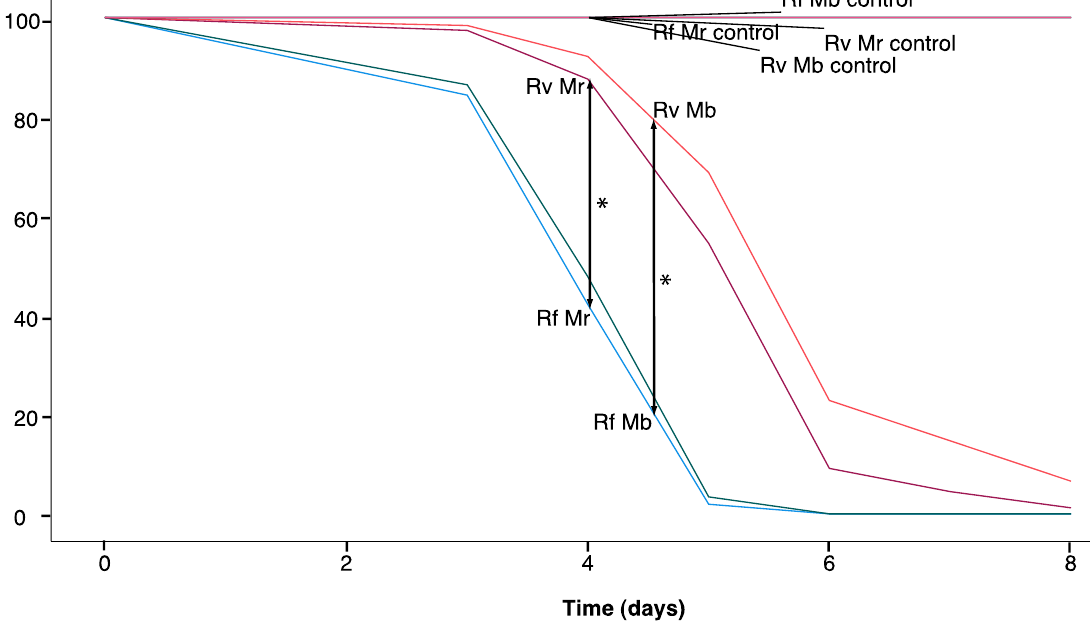
Figure 3. The survivorship of two termites versus one was compared with hazard ratios of death (n = 80 pairs, 96 singletons). Rf corresponds with R. flavipes , Rv with R. virginicus , Mr with M. robertsii and Mb with M. brunneum . Time was log transformed for calculation of the R 2 values. For the survivorship of pathogen-challenged single termites (Figure 4), 47 deaths were observed among 48 individuals, and the mean survival time for R. flavipes (4.21 days) was significantly lower than for R. virginicus (6.17 days)(Breslow, chi-square = 33.927, df = 1, p < 0.001). This relationship held for both species of fungi: For M. robertsii exposure, the mean survival time for R. flavipes (4.25 days) was significantly lower than for R. virginicus (5.83 days) (chi-square = 16.133, df = 1, p < 0.001); For M. brunneum exposure, the mean survival time for R. flavipes (4.17 days) was significantly lower than for R. virginicus (6.50 days) (chi-square = 20.994, df = 1, p < 0.001).